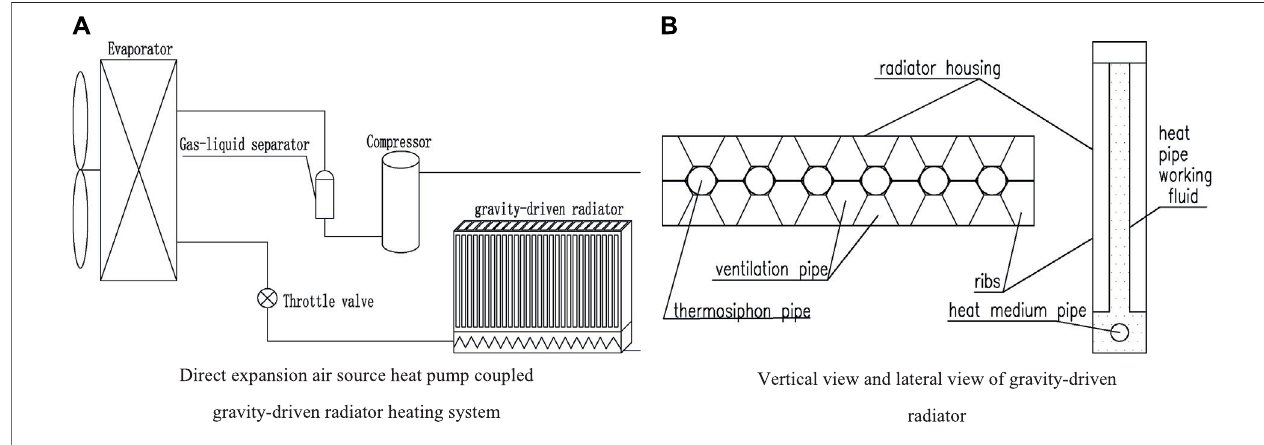
FIGURE 1 | Schematic diagram of direct expansion air-source heat pump system coupled with gravity-driven radiator. (A) Direct expansion air-source heat pump coupled gravity-driven radiator heating system. (B) Vertical view and lateral view of a gravity-driven radiator.